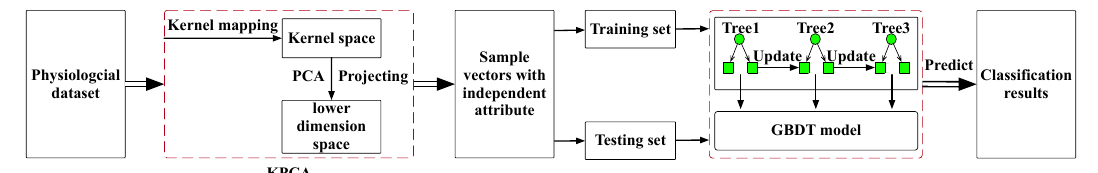
Figure 2. Block diagram of the comprehensive nonlinear processing